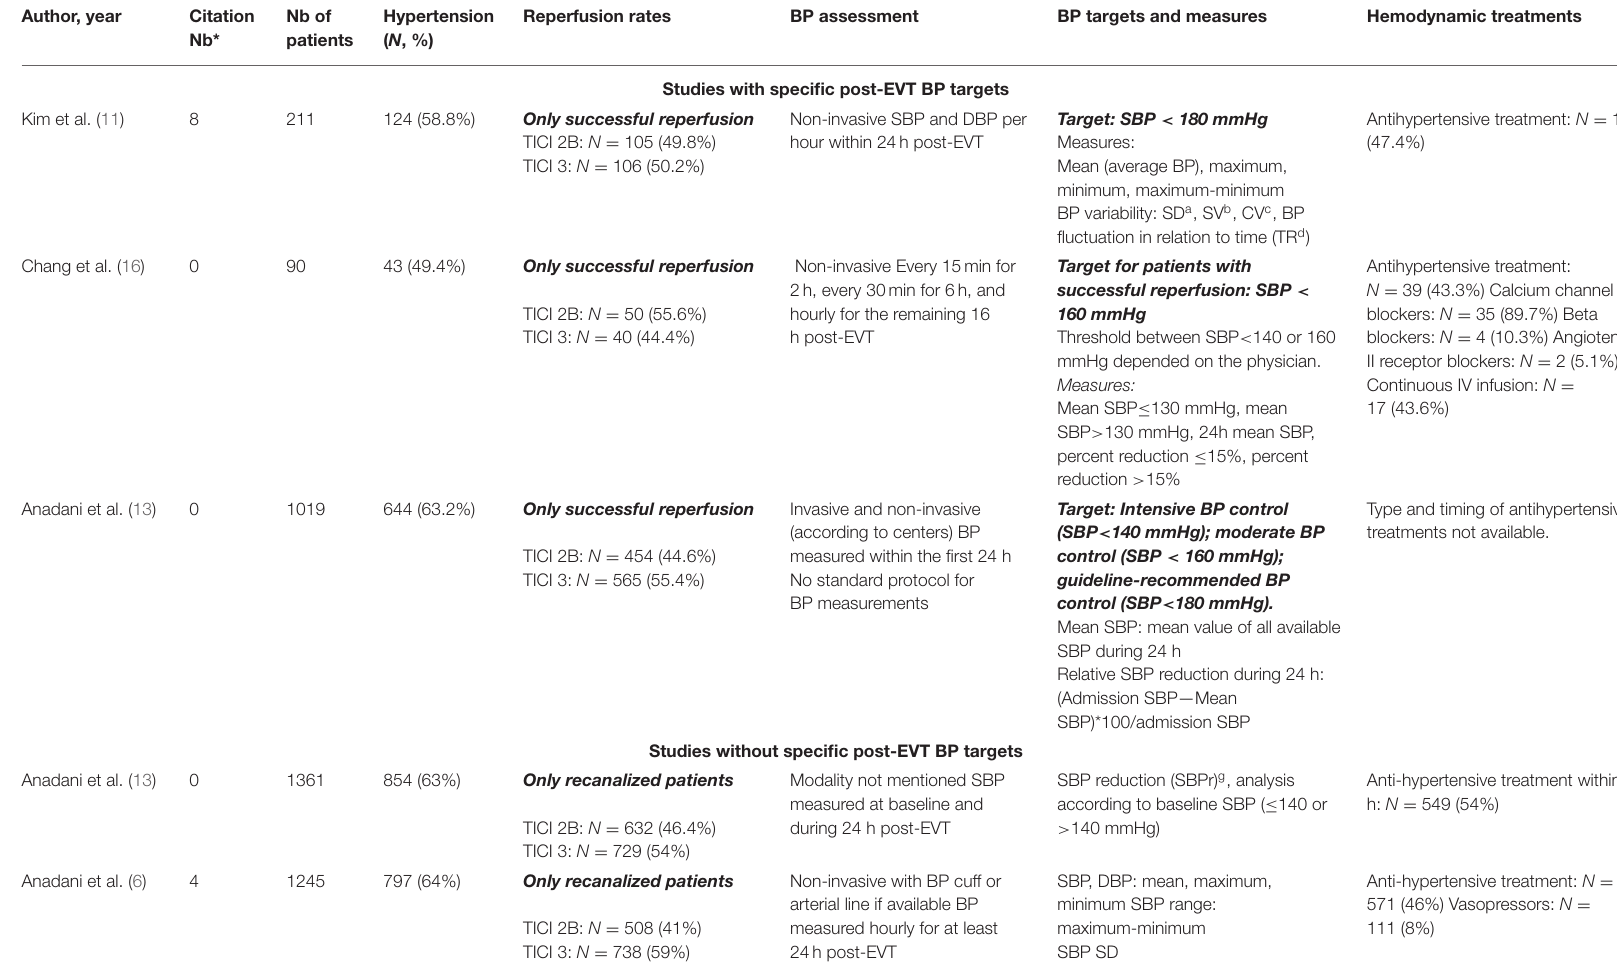
TABLE 1 | Characteristics of included studies with BP targets and BP modality of